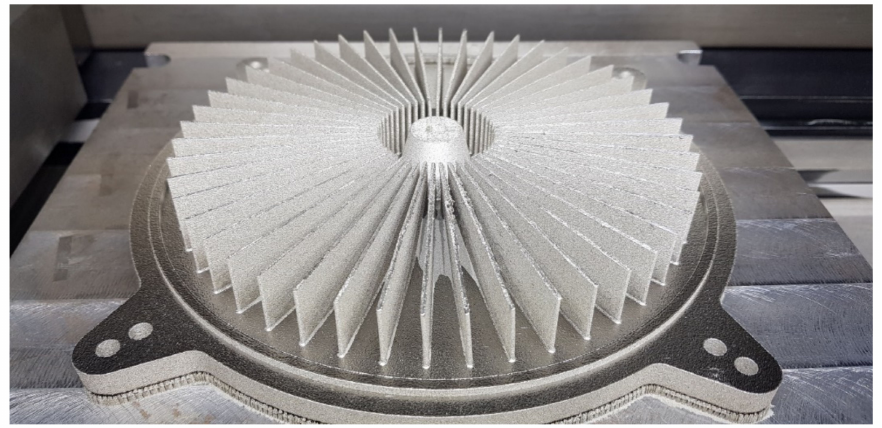
Figure 33. Radiator in the workspace of the EOS M270 variant No.